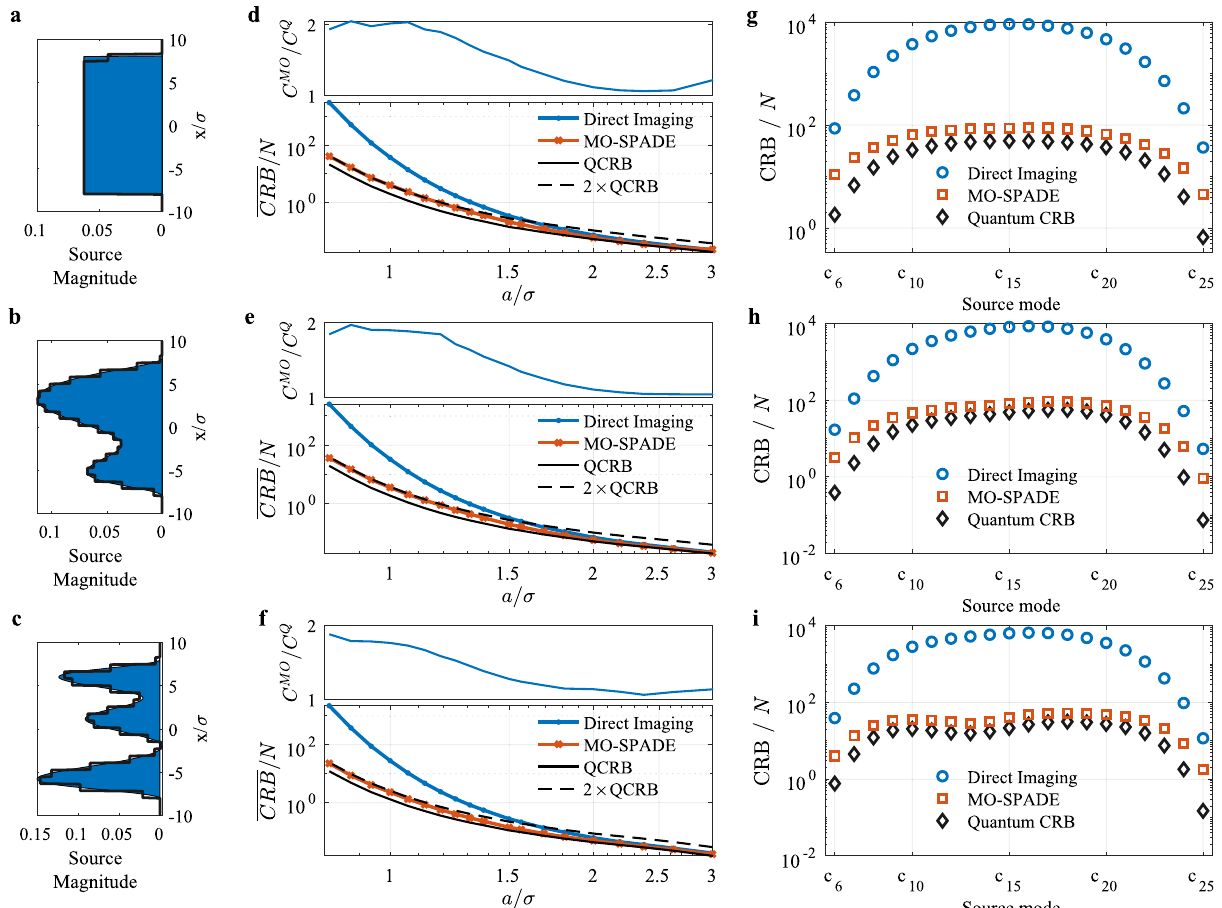
Figure 3. Demonstration of MO-SPADE imaging for extended sources. Each row corresponds to analysis of the source distributions shown in ( a – c ) respectively. The black outline of the sources shows the discretization into rectangle functions with width a = 0.8 σ . ( d – f ) The CRB averaged over all source magnitude coefficients is shown for various source mode rectangle widths a . Smaller widths correspond to a larger number of rectangle functions being used to discretize the source region at a finer resolution. The entire discretized source region extends over ± 12 σ , and J = K + 1 imaging modes are used. The upper panels plot the ratio between the MO-SPADE CRB ( C MO ) and the quantum CRB ( C Q ). ( g – i ) CRB of the nonzero source amplitude coefficients ( c 6 through c 25 ) for a discretization width of a = 0.8 σ